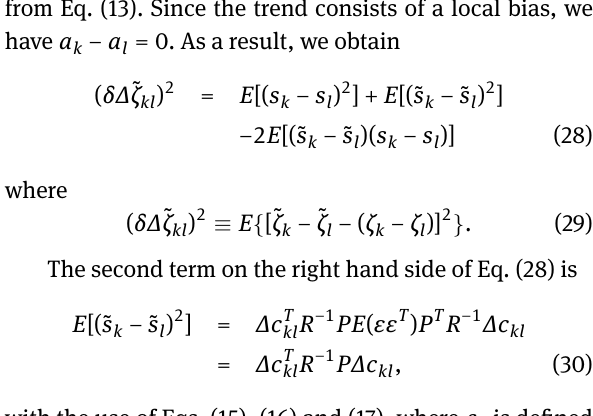
Figure 4: The uncertainty of height anomaly differences of the quasigeoid NMA2013v30 are shown, for locations separated by 1 km. White represents off-scale